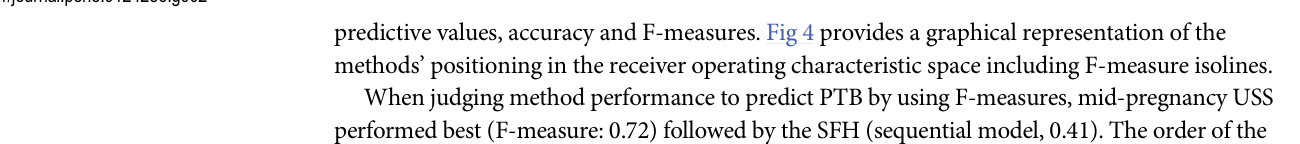
Fig 2. Box-and-Whisker Charts of Estimated GA at Delivery by Method. The continuous bold line denotes the median of the reference and dashed lines denote 5% and 95% centiles of the reference.